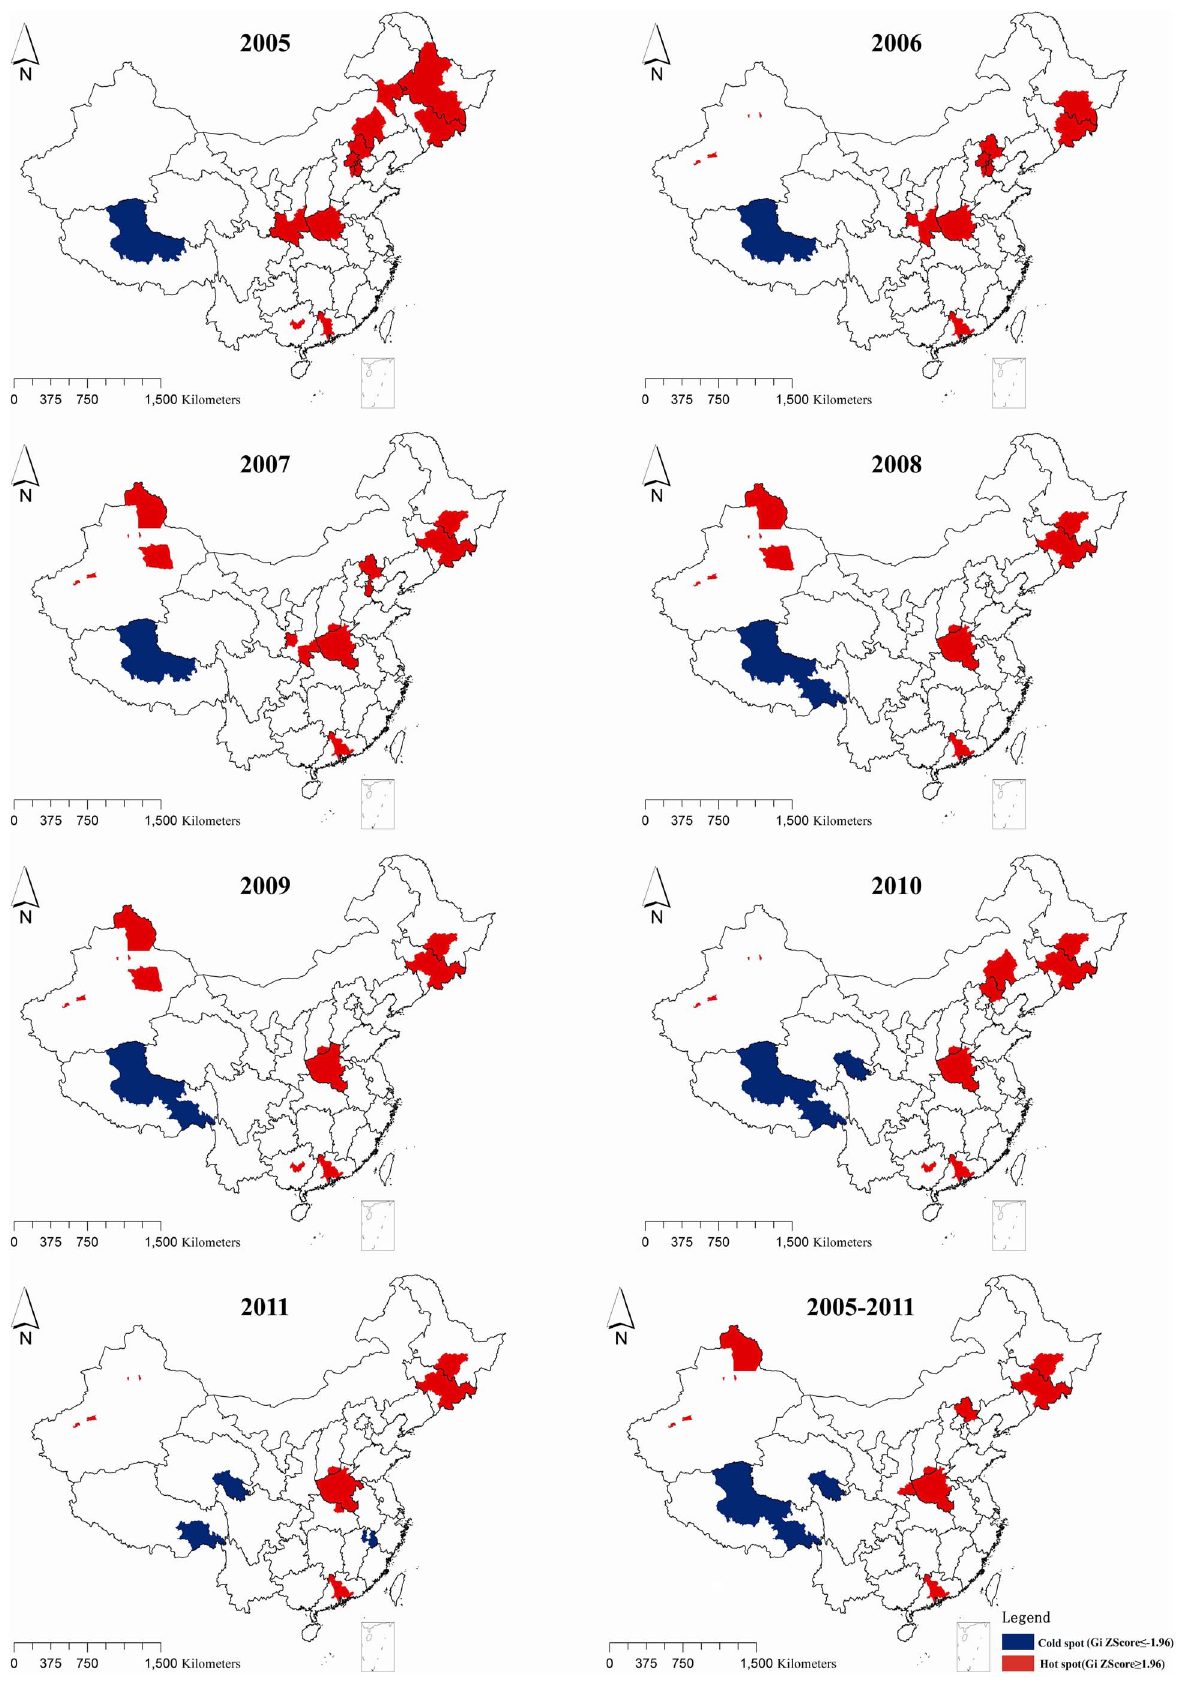
Figure 3. Hotspots and Coldspots of identified HCV infection cases at city level by year in China, 2005–2012. doi:10.1371/journal.pone.0110861.g003 PLOS ONE |